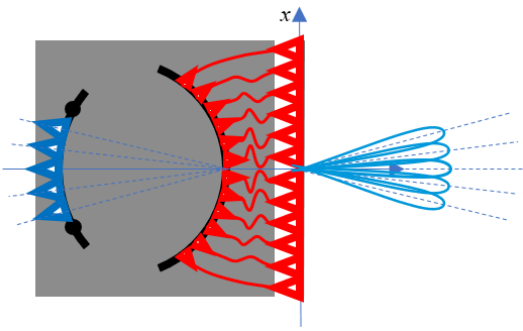
Figure 1. Discrete lens architecture.